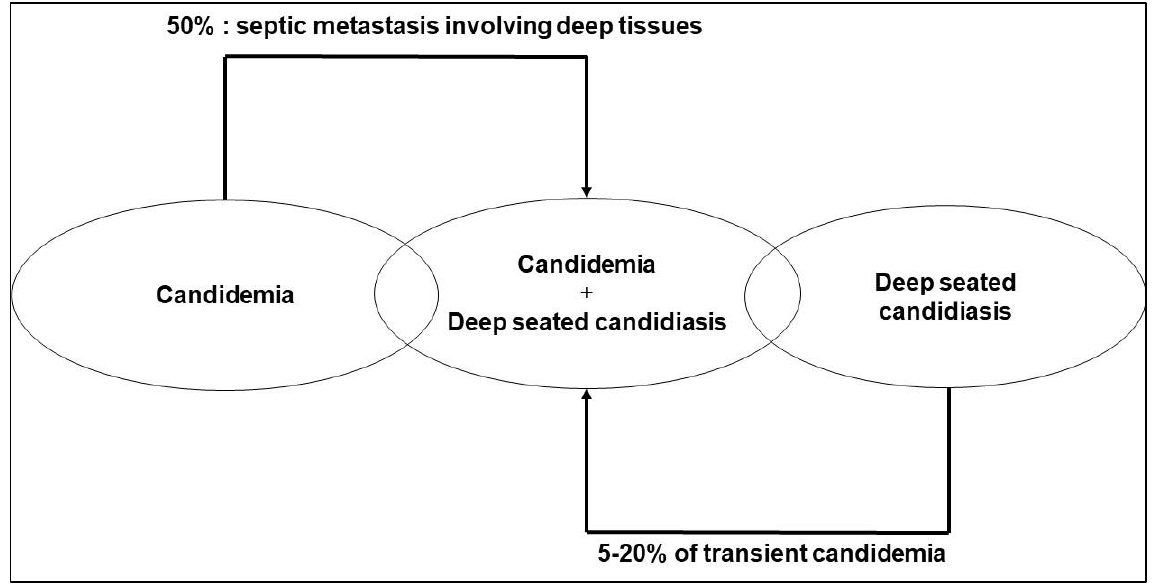
Figure 1. The spectrum of invasive candidiasis.